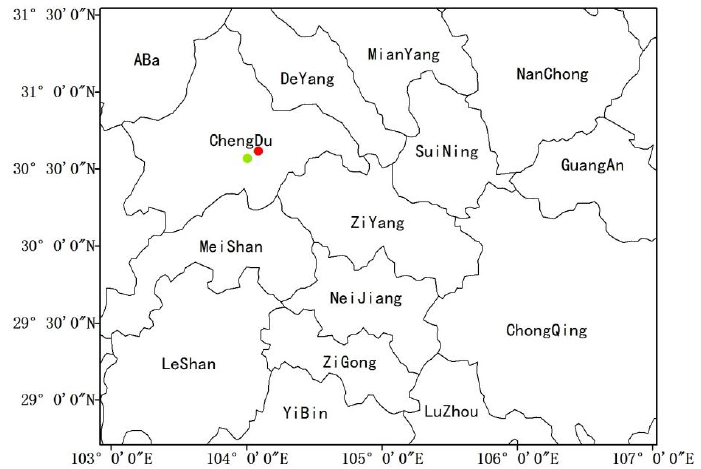
Figure 2. The locations of the automatic air-monitoring substation in Sichuan Province and